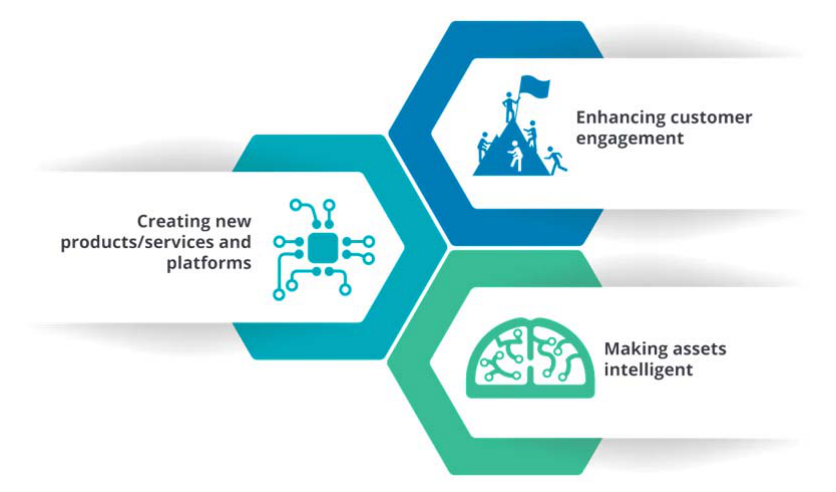
Figure 4. Three levels of digital Transformation at Aerospace and defense enterprises